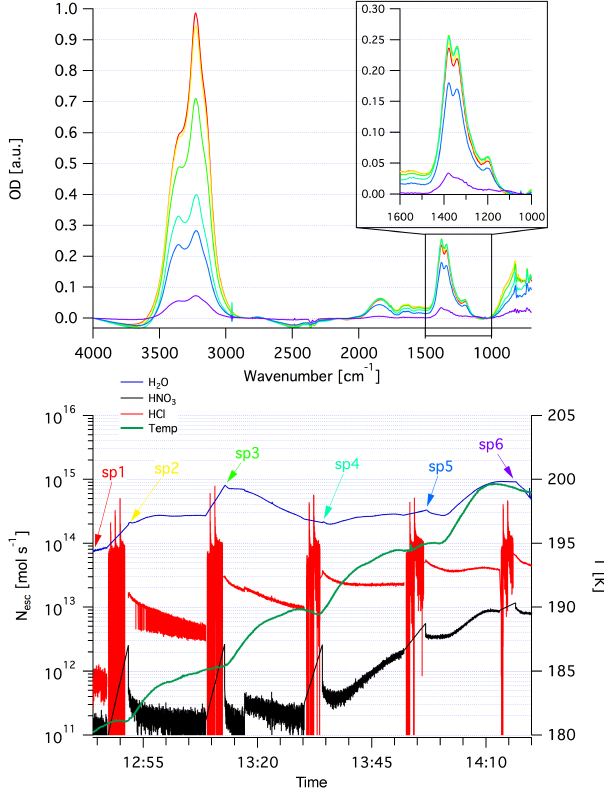
Figure 7. Repetitive PV (pulsed-valve) deposition experiment of HCl on an β -NAT/ice substrate under SFR conditions followed by MS (lower panel) and FTIR transmission across the thin film (up- per panel) as a function of time. In the lower panel the temperature is displayed as the green trace; the red MS signal represents HCl at m/e 36amu with the pulsed forcing recognizable as single peaks (11) on top of the red columns. The individual HCl doses corre- spond to approximately (6–7) × 10 16 molecule per pulse resulting in a total dose of 4 × 10 17 molecules. The blue and black traces rep- resent the response of H 2 O ( m/e 18amu) and HNO 3 ( m/e 46amu) as a function of time (temperature) and HCl forcing. The upper trace displays FTIR transmission spectra at selected times indicated in the lower panel through color coding. The principal peak positions are listed in Table 3, and the changes are discussed in the